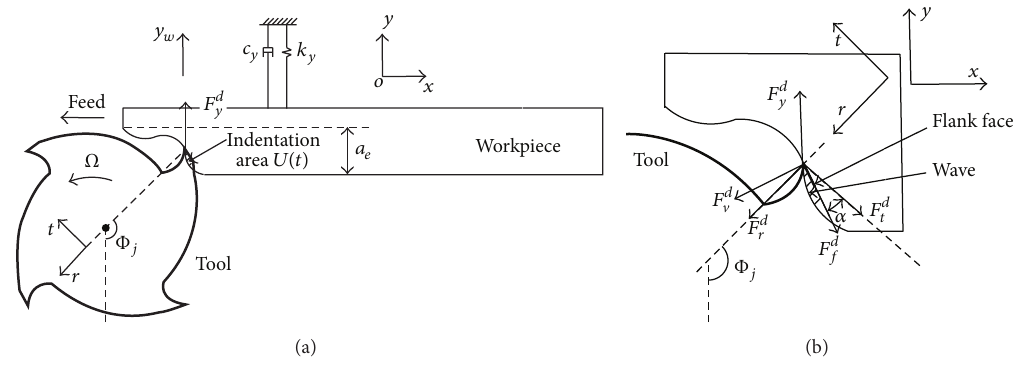
Figure 1: End milling system